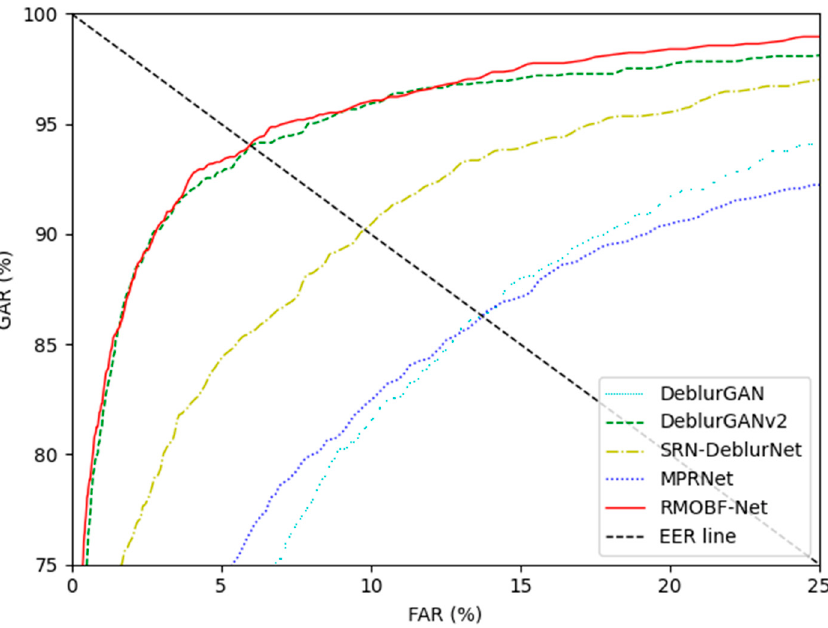
Figure 34. ROC curves of finger-vein recognition with PolyU-DB for scheme 5 by various restoration methods (random motion blur and optical blur with intensity 15 × 15 (Gaussian filter size) and 15 (Gaussian filter standard deviation)).